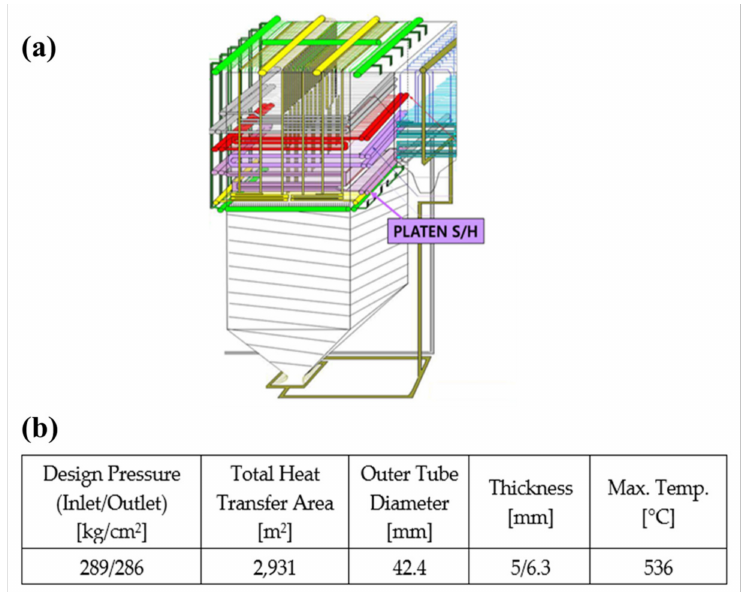
Figure 1. ( a ) Overview of a Korean standard coal-fired power plant PSH, ( b ) operating conditions.